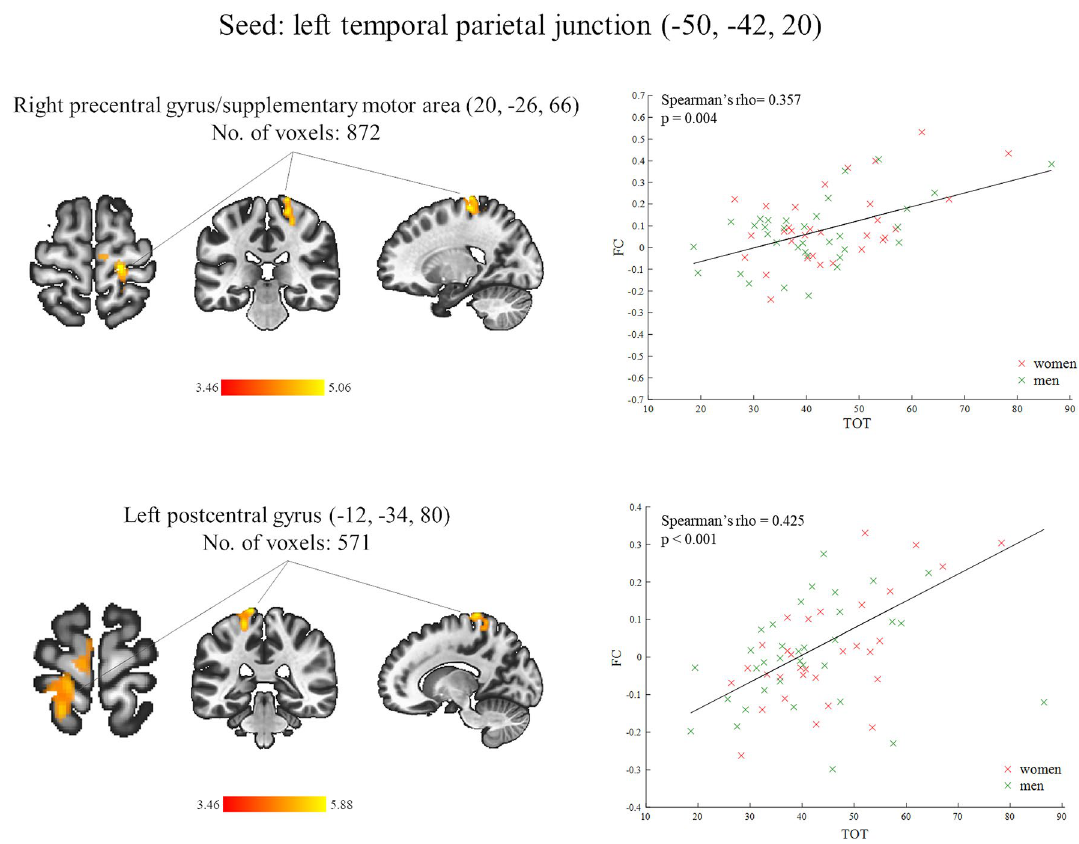
Figure 3. (Left) Brain regions demonstrating a significant positive association between the temporal order threshold (TOT) values and functional connectivity (FC) values after controlling for the influence of fluid intelligence (G f factor), interaction between the TOT and G f and gender. The left temporal parietal junction is the seed region with the Montreal Neurological Institute (MNI) coordinates of its center position placed in the bracket. The number of voxels is the size of the whole target region (in voxels 2 × 2 × 2 mm), and the name indicates the anatomical area the majority of the voxels belonged to. The color bars represent T scores. (Right) Scatter plots of functional connectivity (FC) parameters as a function of the temporal order threshold (TOT) at the peak voxel of each target region. The FC values for women are marked in red and for men in green. The black solid line represents a best fit for linear regression on a datasets with outliers (fit robust linear regression). The values of Spearman’s rho coefficients that measure the strength of association between the TOT and FC and their significance levels (p) are placed in the left upper corner of each scatter